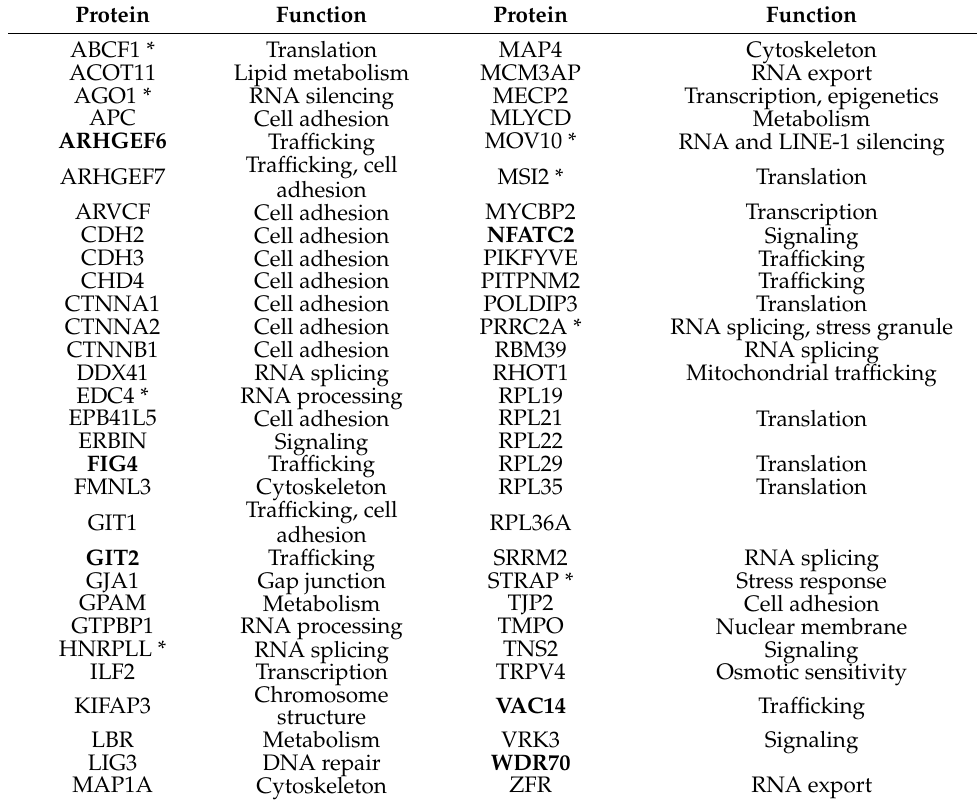
Table 6. High-confidence OTX2 putative protein partners in choroid plexus identified by MS analysis. Proteins indicated in bold are unique for OTX2 co-IP, proteins with * are “tier 1” stress granule